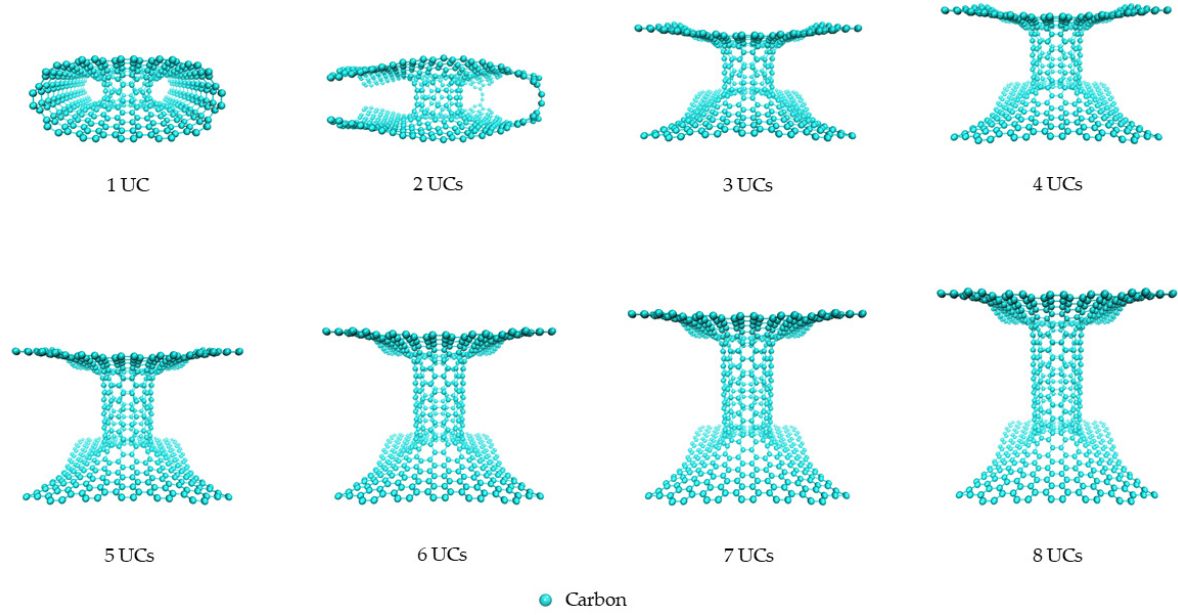
Figure 3. The 3D pillared C (6,6) nanostructures with various pillar lengths after full geometry optimization by the SCC-DFTB method. Table 1. Summary of the pillar lengths of 3D SiC and C nanostructures before and after geometry optimization by the SCC-DFTB